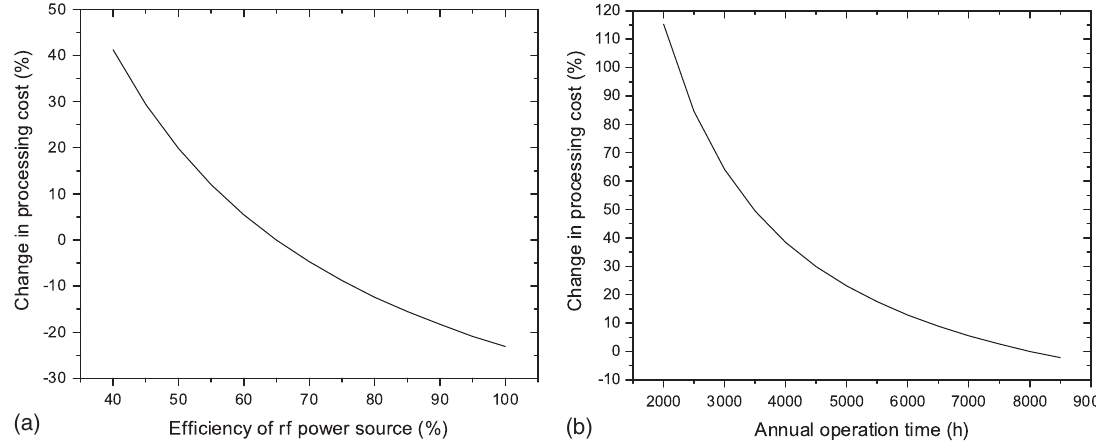
FIG. 29. Processing cost dependence on rf driver efficiency (a) and annual operation time